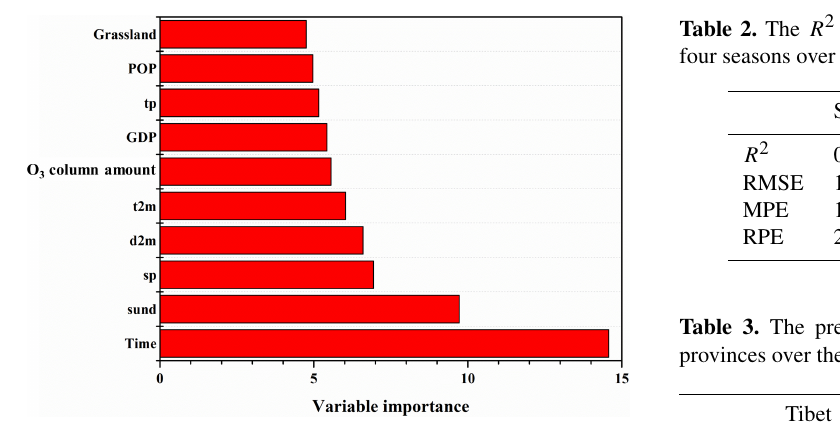
Figure 5. The variable importance of predictors in the final RF– GAM model.